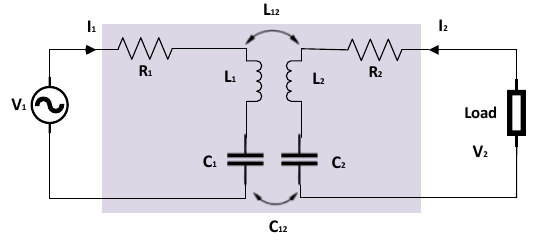
Figure 7. Equivalent network of a mixed WPT setup A mixed WPT system with series topology